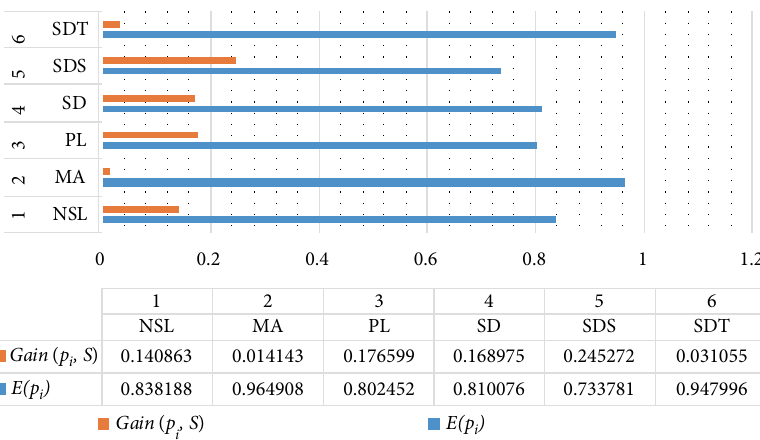
Figure 3: Information gain for attribute set.